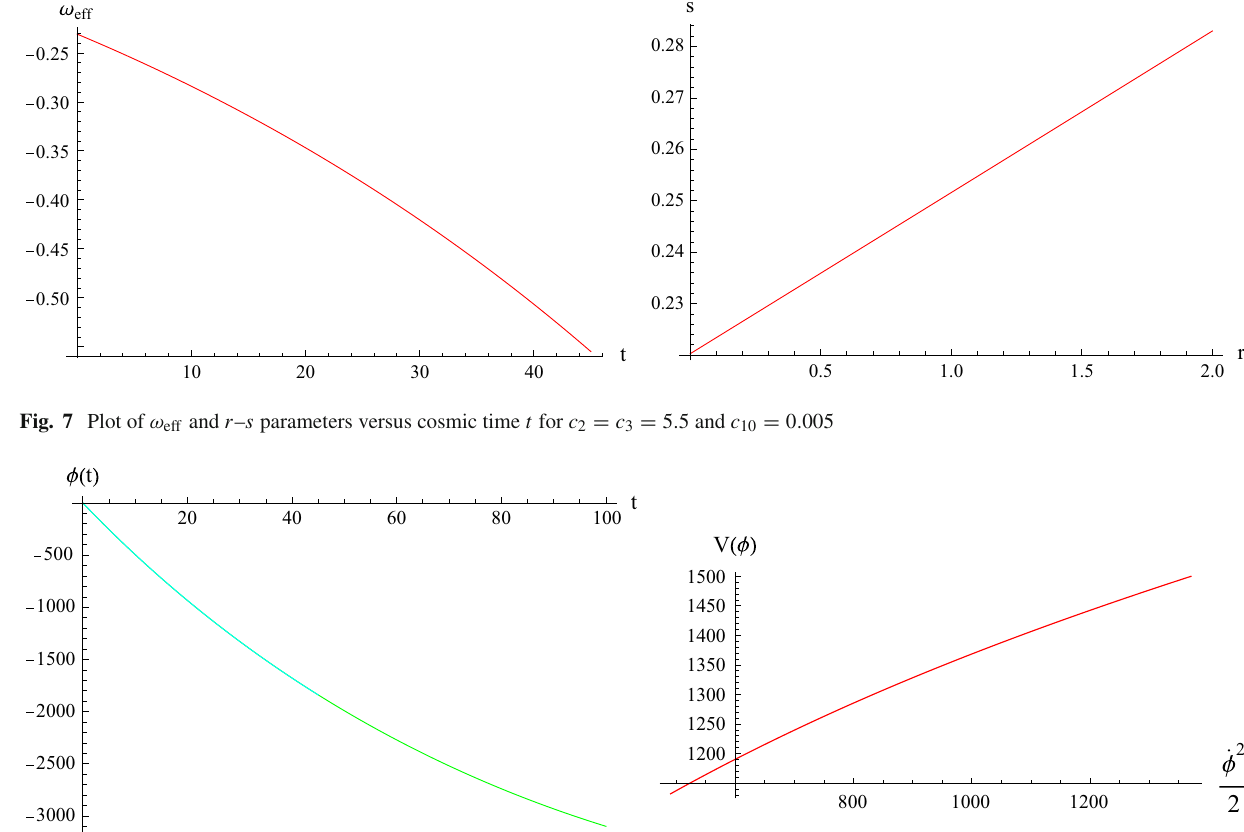
Fig. 8 Plots of scalar field φ( t ) ( left ) versus cosmic time t and potential energy V (φ) versus kinetic energy c 6 = 0 . 5 and c 10 = 0 .